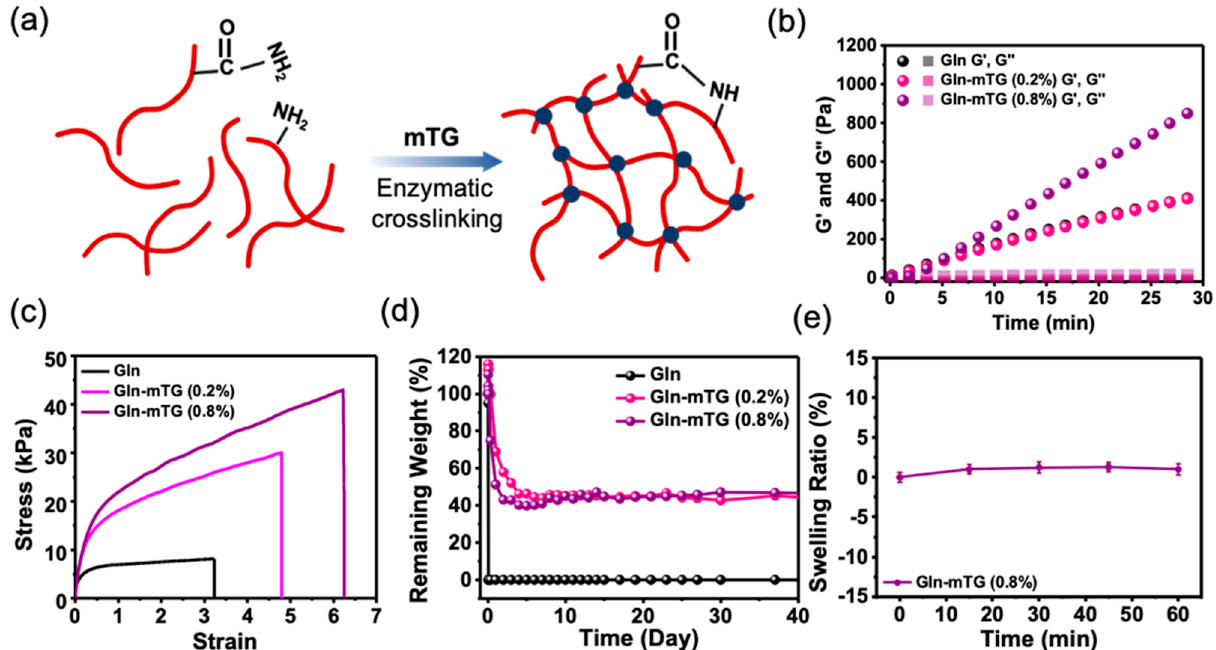
Figure 4. ( a ) A schematic drawing demonstrating that the mTG catalyzes the chemical crosslinking that leads to the formation of mechanically robust Gln hydrogels. ( b ) The storage and loss modulus, G ′ and G ″ respectively, versus time of Gln with different concentration of mTG. ( c ) The stress–strain curves of Gln and Gln-mTG. ( d ) The degradation profiles showing the remaining weight over time. ( e ) The swelling ratio of Gln-mTG (0.8%) over time. Table 1. Mechanicial Properties obtained from stress-strain curves of Gln and Gln-mTG hydro- gels. Young‘s Modulus Strain